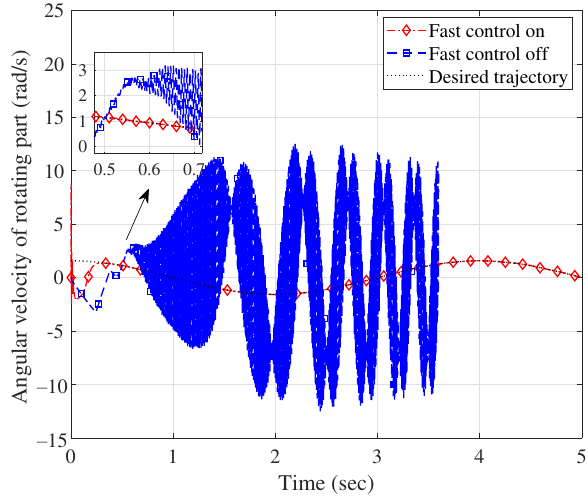
Figure 25. Angular velocity of rotating part (Group 4).